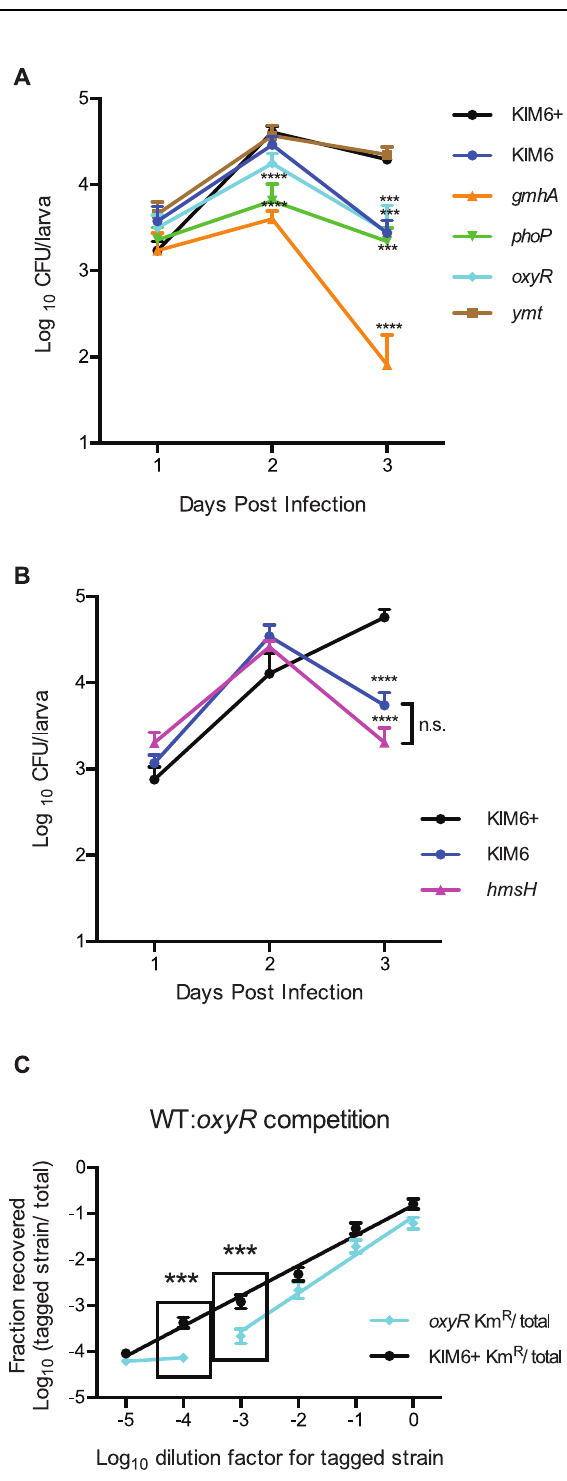
Fig 4. Decreased survival in flies of Y . pestis mutants. (A) Drosophila larvae were infected with the indicated strain of Y . pestis one day after hatching. Bacterial survival rate was determined by homogenizing larvae and plating on YSA on the indicated day post infection. Cultures were incubated at room temperature for two days before colonies were counted. For each trial, infections were performed in triplicate, and each strain was subjected to a minimum of three independent trials. Data from trials were pooled and averaged. Means (n (cid:1) 15 per strain per day) and standard error are shown. ANOVA with Dunnett post-test was done to compare mutants to the KIM6+ control for each day. *** P < 0.001, **** P < 0.0001. (B) Larvae were